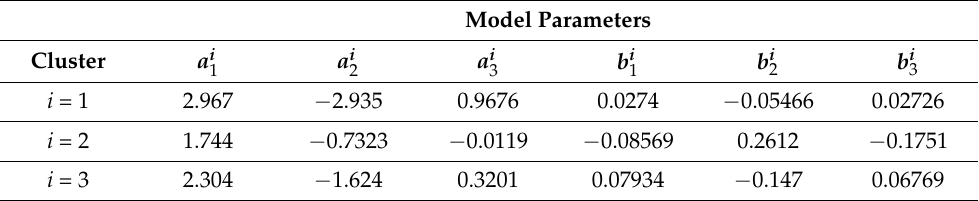
Table 2. The model parameters that are identified by the proposed method with τ = 0.5.